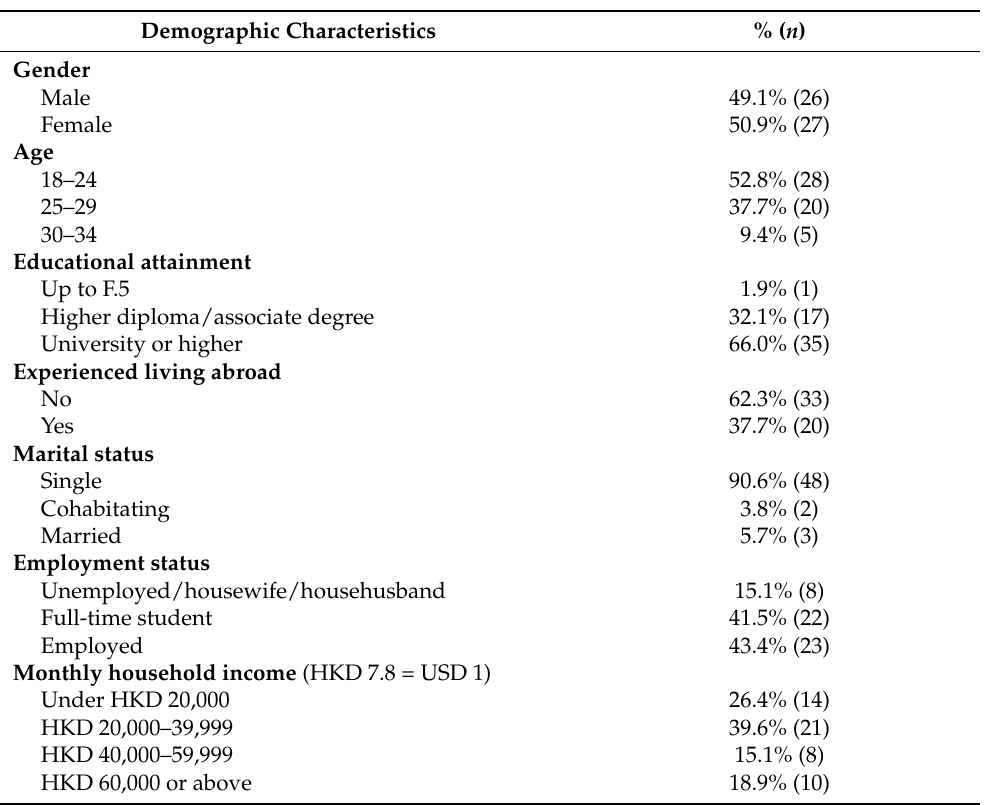
Table 1. Demographic characteristics of the Hong Kong young adult focus group participants aged 18–34 ( n =